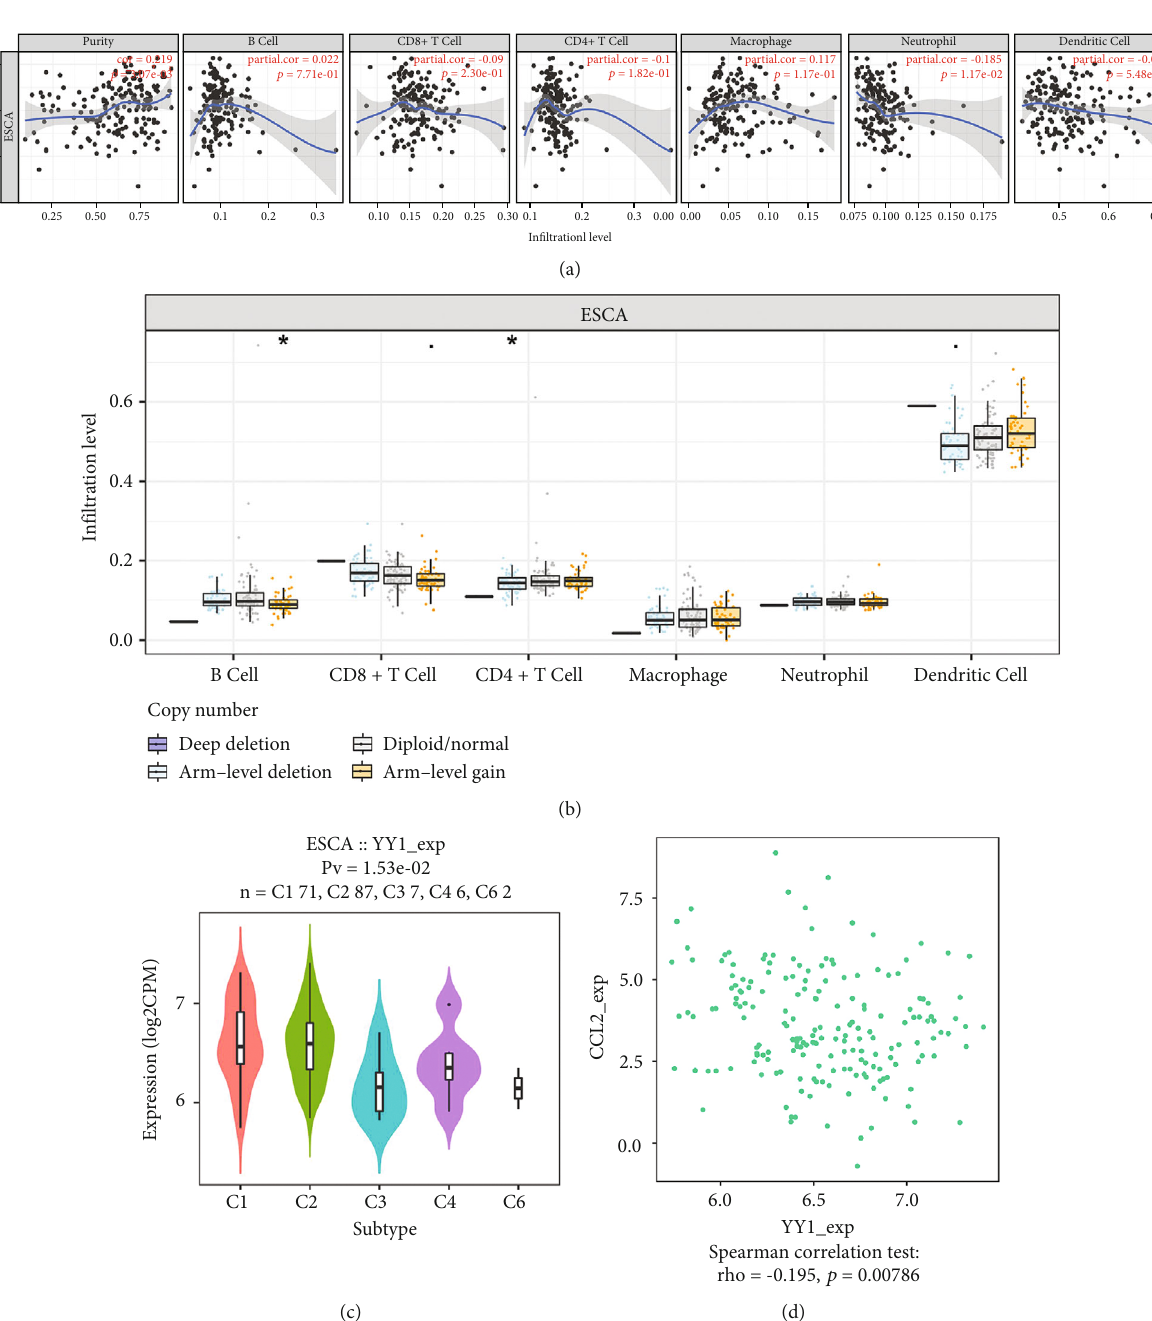
Figure 4: The association of YY1 with immune in fi ltration in ESCA. (a) YY1 expression is signi fi cantly associated with tumor purity and in fi ltrating of immune cells. (b) YY1 CNV a ff ects the in fi ltrating of immune cells. (c) The association between YY1 expression and immune subtype using TISIDB: C1: wound healing; C2: IFN-gamma dominant; C3: in fl ammatory; C4: lymphocyte depleted; C5: immunologically quiet; C6 (TGF-b dominant. (d) The association between YY1 and chemokine. ∗ P < 0 : 05